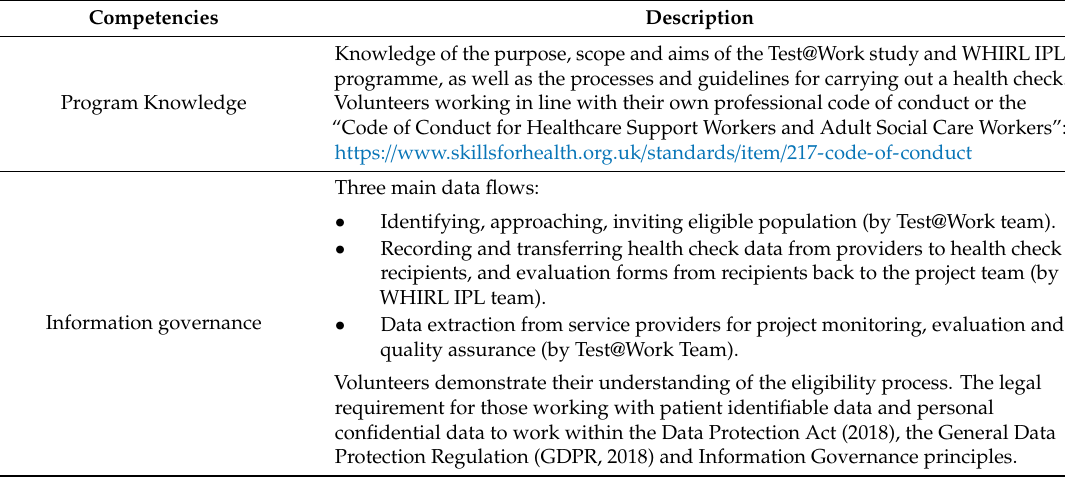
Table 1. Competencies for WHIRL (Workplace Health InteRprofessional Learning) interprofessional learning (IPL)